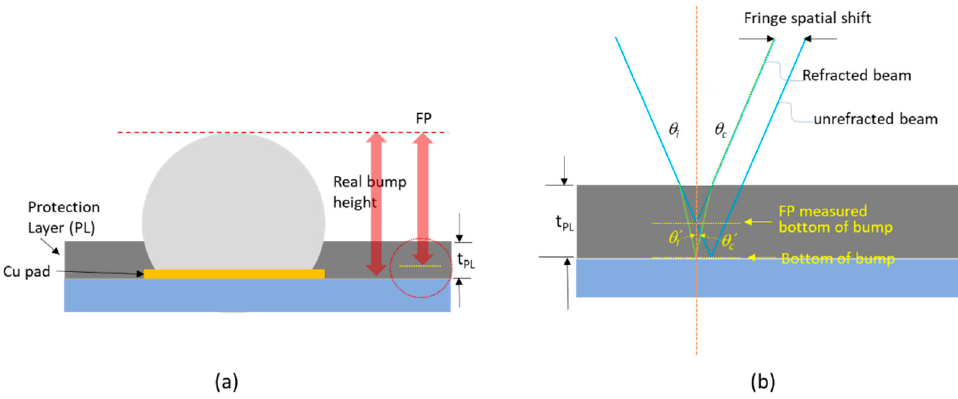
Figure 5. ( a ) UFI process uses a protective layer that is semitransparent and varies in thickness. This introduces a significant error in the bump height/coplanarity measurement. ( b ) Spatial shift of fringes due to traveling around the PL layer.